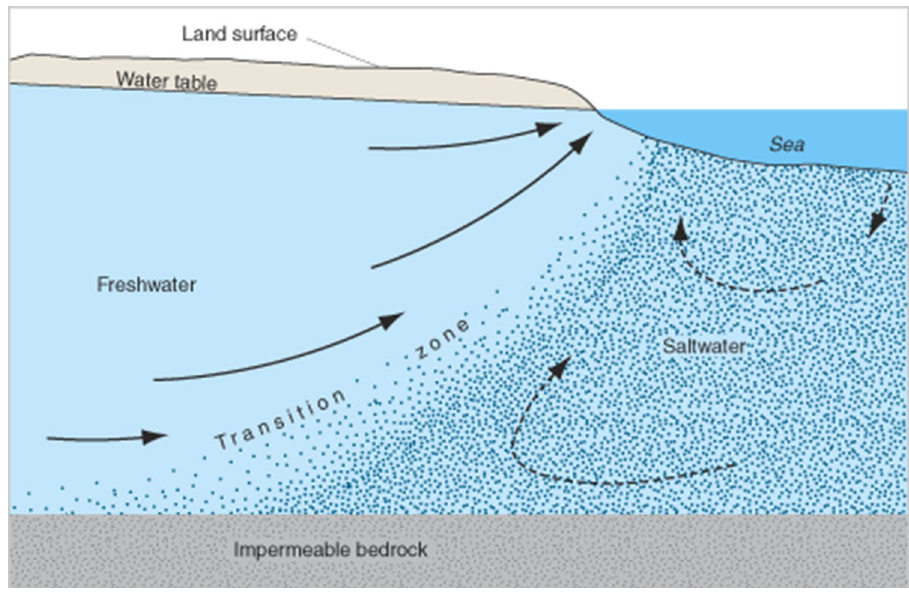
Fig. 1 Groundwater flow patterns and the freshwater– saltwater transition zone in an idealized coastal aquifer (Cooper